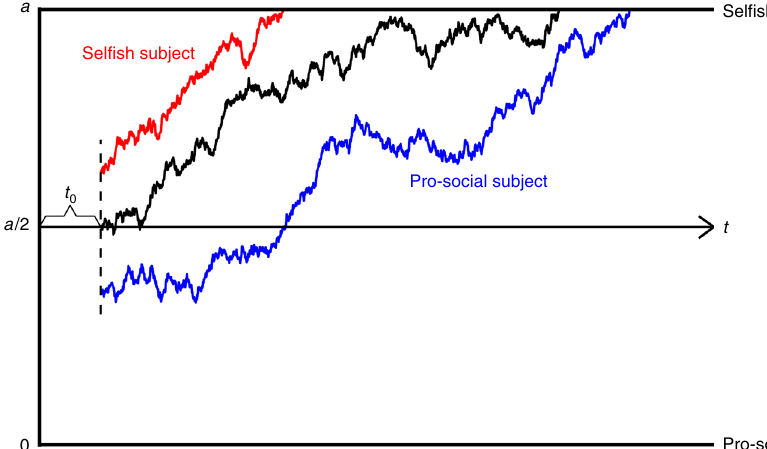
Fig. 4 A graphical illustration of the DDM. 0 and a are the two preset thresholds for the pro-social option and the sel fi sh option, and a is a free parameter. Non-decision time, t 0 , denotes the time required for encoding the stimulus and decision execution. The three paths indicate the evolution of the relative evidence ( R ) over time. The red path which starts near the threshold of the sel fi sh option represents the DDM process for a subject with a response bias towards the sel fi sh option; the blue path which starts near the threshold of the pro-social option represents the DDM process for a subject with a response bias towards the pro-social option; and the black path represents a DDM process without starting point bias (unbiased